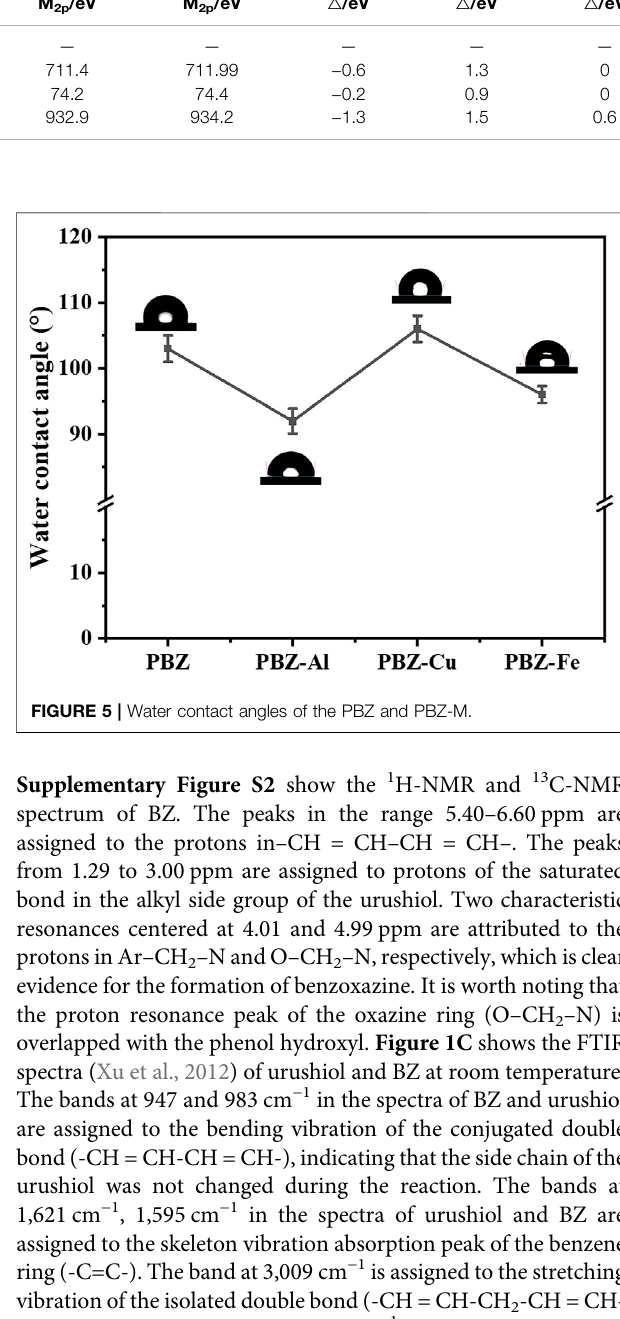
TABLE 3 | The XPS analysis of PBZ and PBZ-M. Polymer